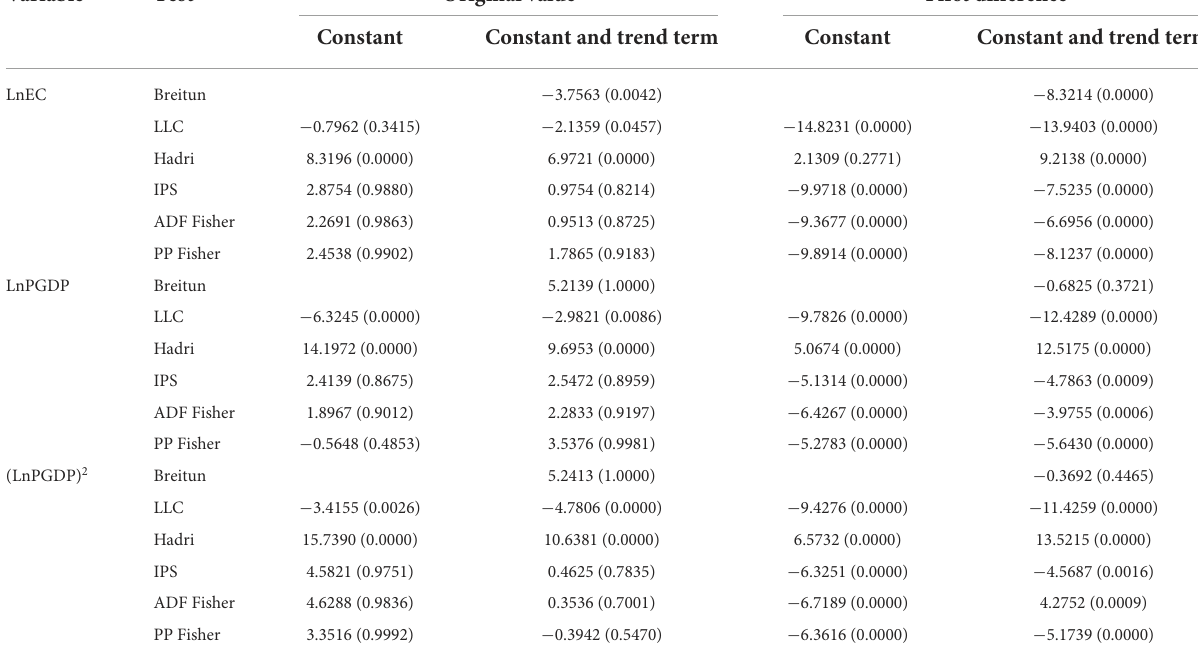
TABLE 2 Panel unit root test